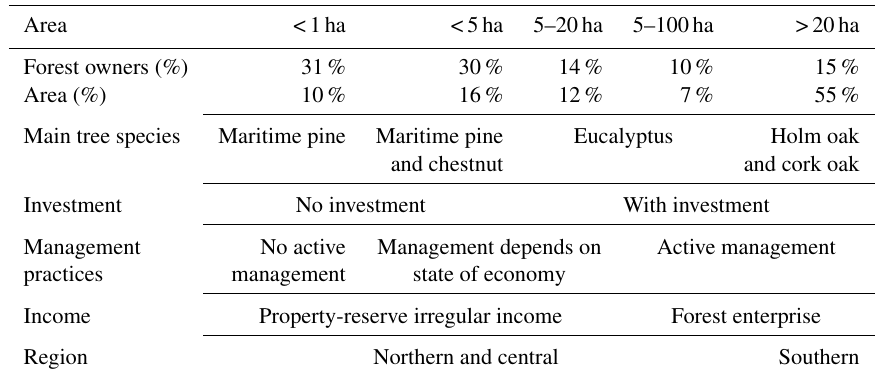
Table A2. Main characteristics of a sample of forest holdings and forest owners studied by Baptista and Santos (2005). Adapted from Feliciano et al.